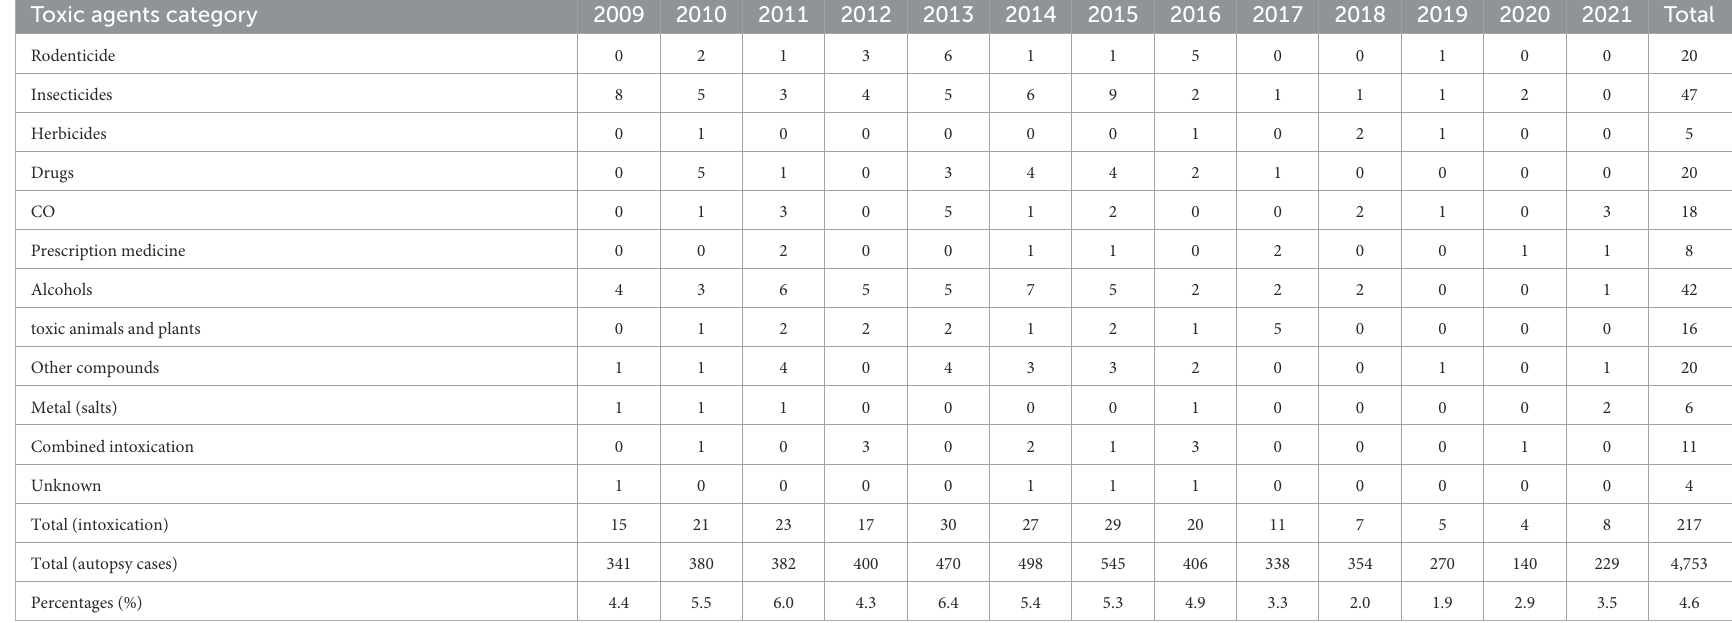
TABLE 1 The different intoxication agents and the number of poisoning deaths per year from 2009 to